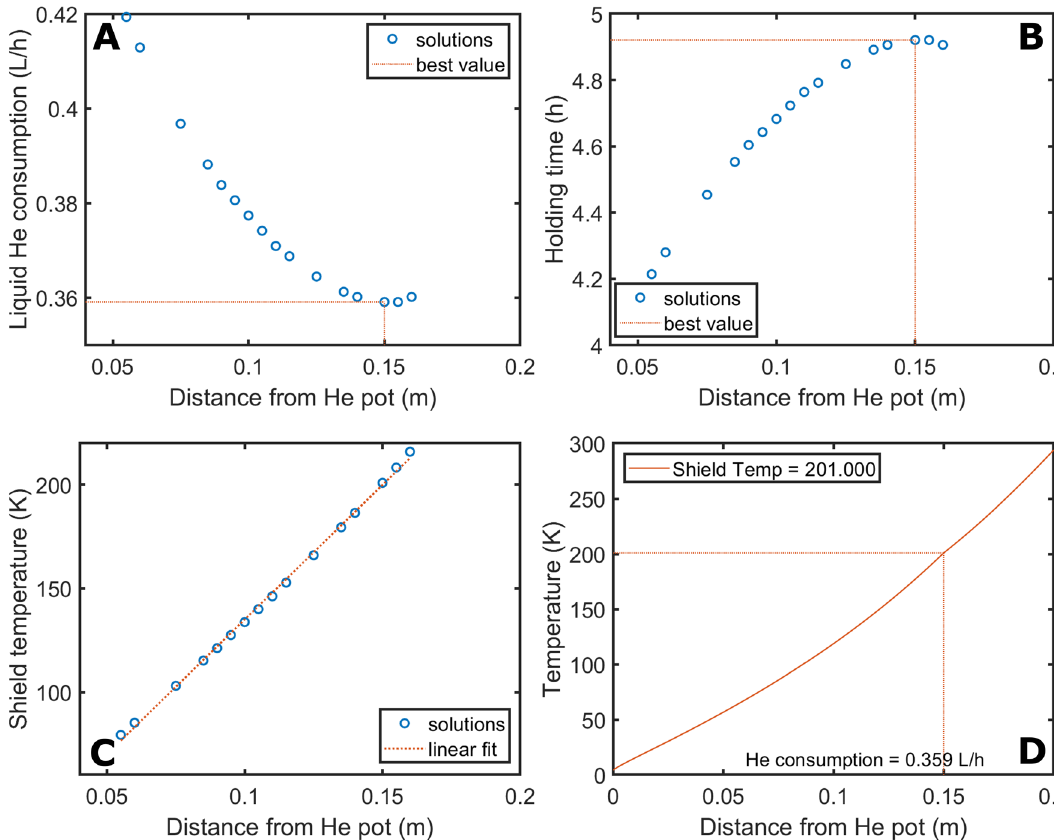
Figure 10. Liquid He consumption as a function of the radiation shield position over a neck length of 200 mm; the orange lines indicate the solution providing the lowest consumption ( A ). The corresponding holding time is reported in ( B ). Shield temperature as a function of its position; the dotted red line represents a linear fit ( C ). Temperature profile for the lowest consumption configuration; the horizontal and vertical lines indicate temperature and position of the radiation shield, respectively ( D